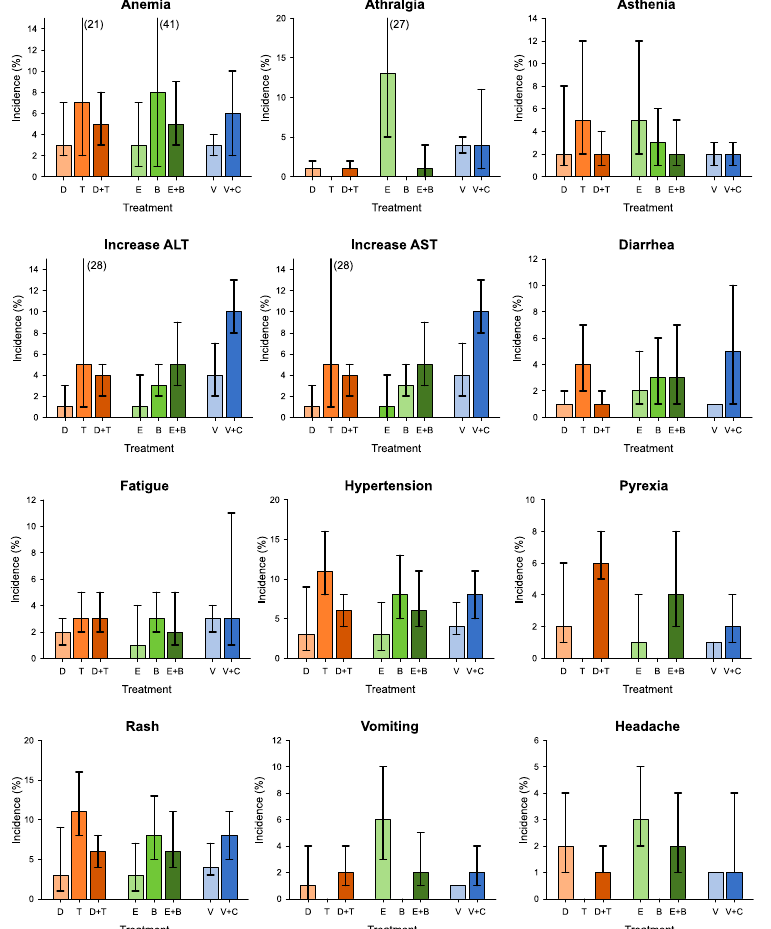
Figure 5. Summary estimates of incidence (%) and corresponding 95% confidence interval of adverse events of grade 3 or higher according to treatment. ALT: alanine aminotransferase; AST: aspartate aminotransferase; C: Cobimetinib; D: Dabrafenib; E: Encorafenib; EF: ejection fraction; T: Trametinib; V: Vemurafenib. Grade 5 adverse events were registered in each treatment group. One case of intra-